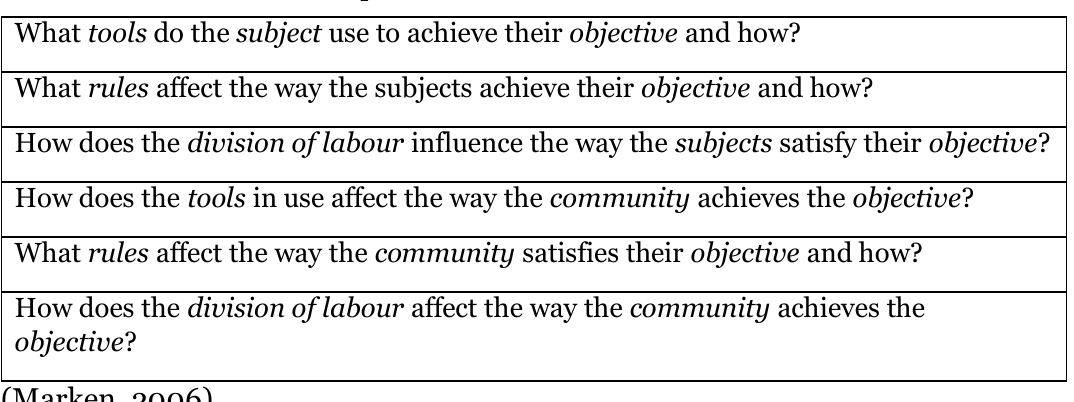
Table 4: Marken’s interview protocol